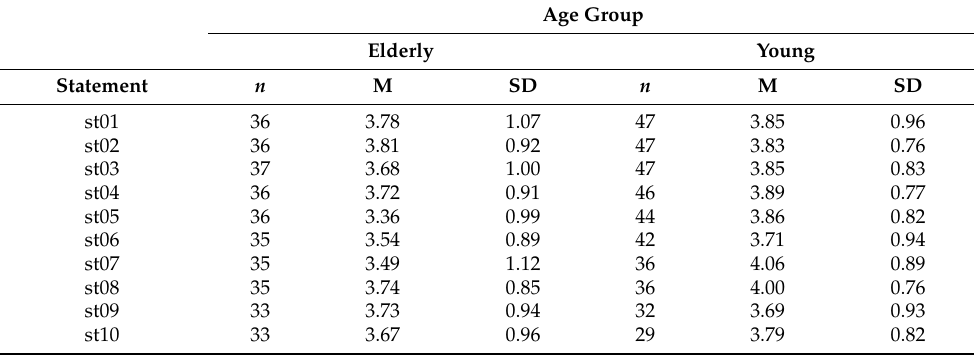
Table 3. Descriptive statistics of the personal relevance score in each statement by age